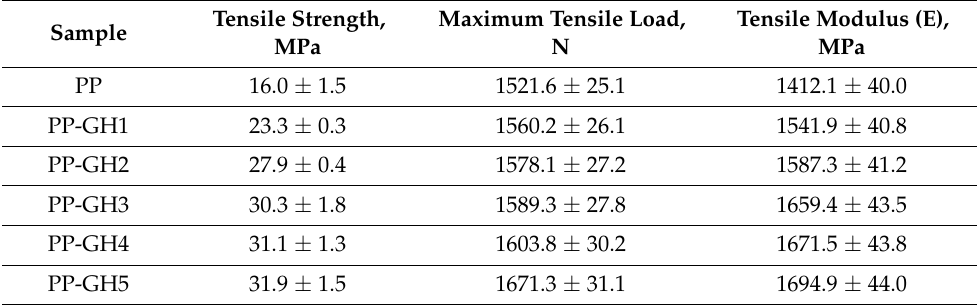
Figure 2. ( a ) Tensile strength, ( b ) maximum tensile load, and ( c ) tensile modulus of the polypropylene (PP)/GNP nanocomposites as a function of the GNP content. Table 3. Extracted data pertaining to tensile properties.